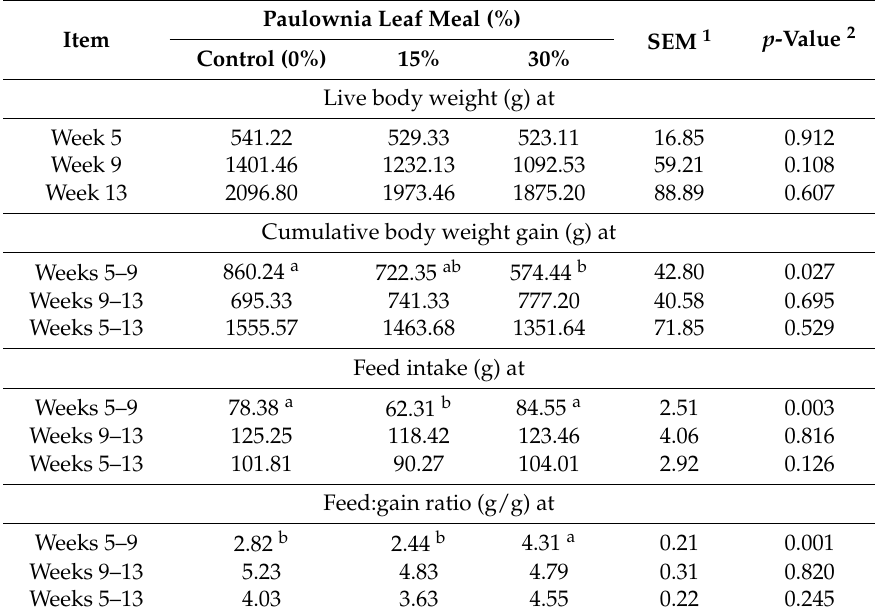
Table 3. Effects of paulownia leaf meal on the performance of New Zealand White rabbits during the fattening